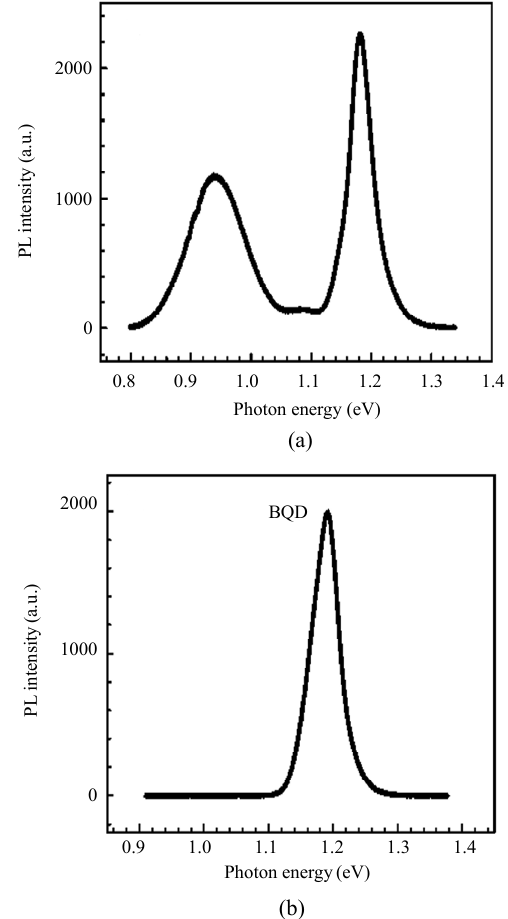
Fig. 3 PL spectra measured at T =70 K: (a) PL spectrum of the coupling sample and (b) PL spectrum of the reference